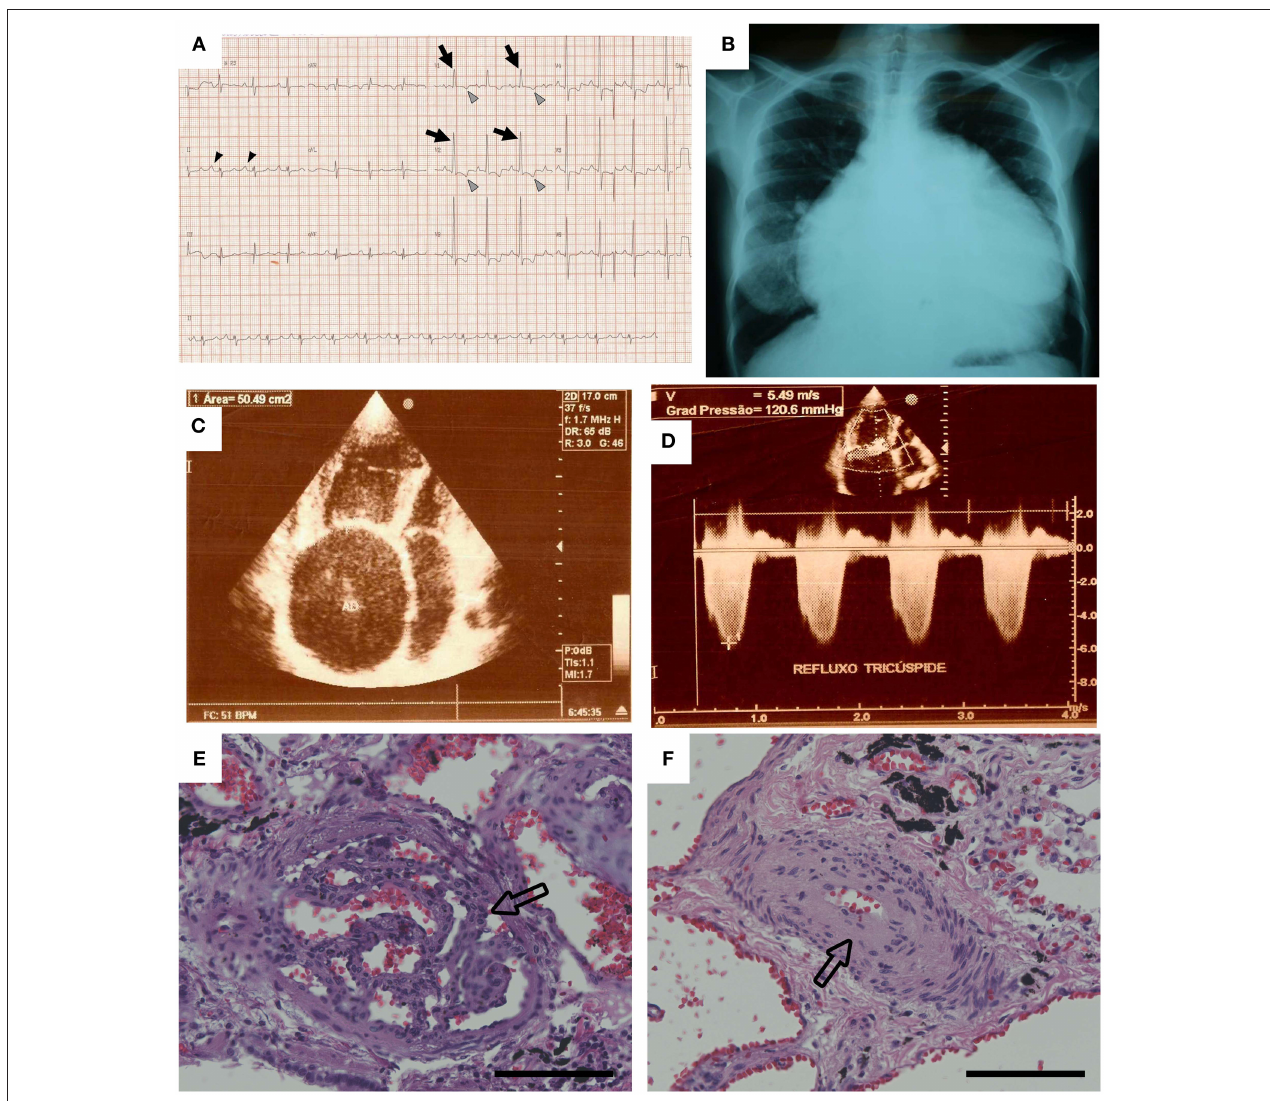
FIGURE 1 | Data from the case example. (A) The patient’s electrocardiogram showed evidence of right atrial enlargement (black arrowheads) and right ventricular hypertrophy. Arrows show large R waves, and gray arrowheads show inverted T waves in V1 and V2. (B) The chest radiograph showed severe cardiomegaly. (C,D) Echocardiography revealed severe enlargement of the right atrium and right ventricle, and Doppler examination of the tricuspid valve resulted in an estimated pressure gradient of 120mm Hg. Pulmonary pathology found on autopsy included (E) plexiform lesions and (F) concentric intimal thickening. Hematoxylin and eosin stain, original magnification × 20. Scale bars are 100 µ m [Reprinted with permission from Graham et al.